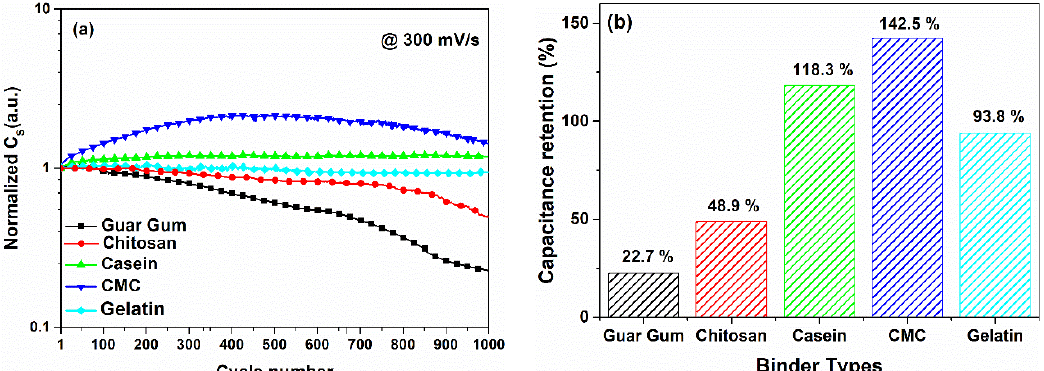
Figure 8. ( a ) Cycles stability of the SCs investigated in 1 M of NaCl performed with 1000 CV cycles at 300 mV/s in the voltage range between 0 and 1 V; ( b ) comparison of the capacitance retention after 1000 cycles at 300 mV/s as a function of the binder types .